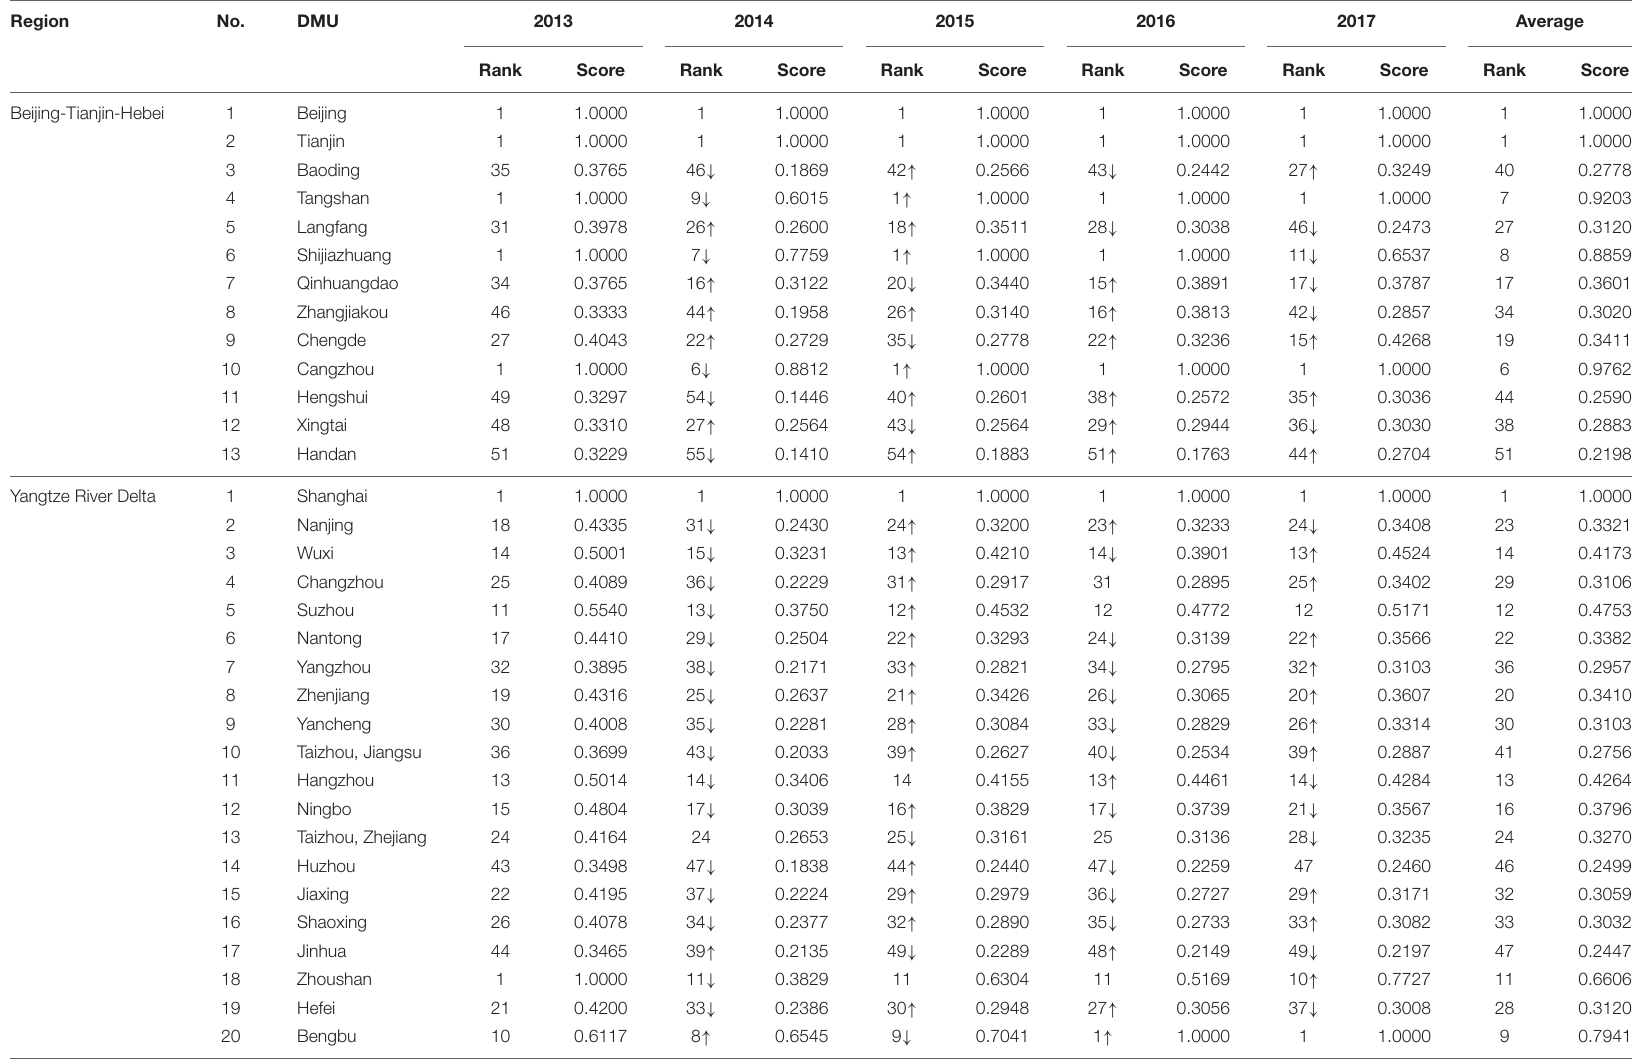
TABLE 4 | Overall efficiency and ranking. Region No.